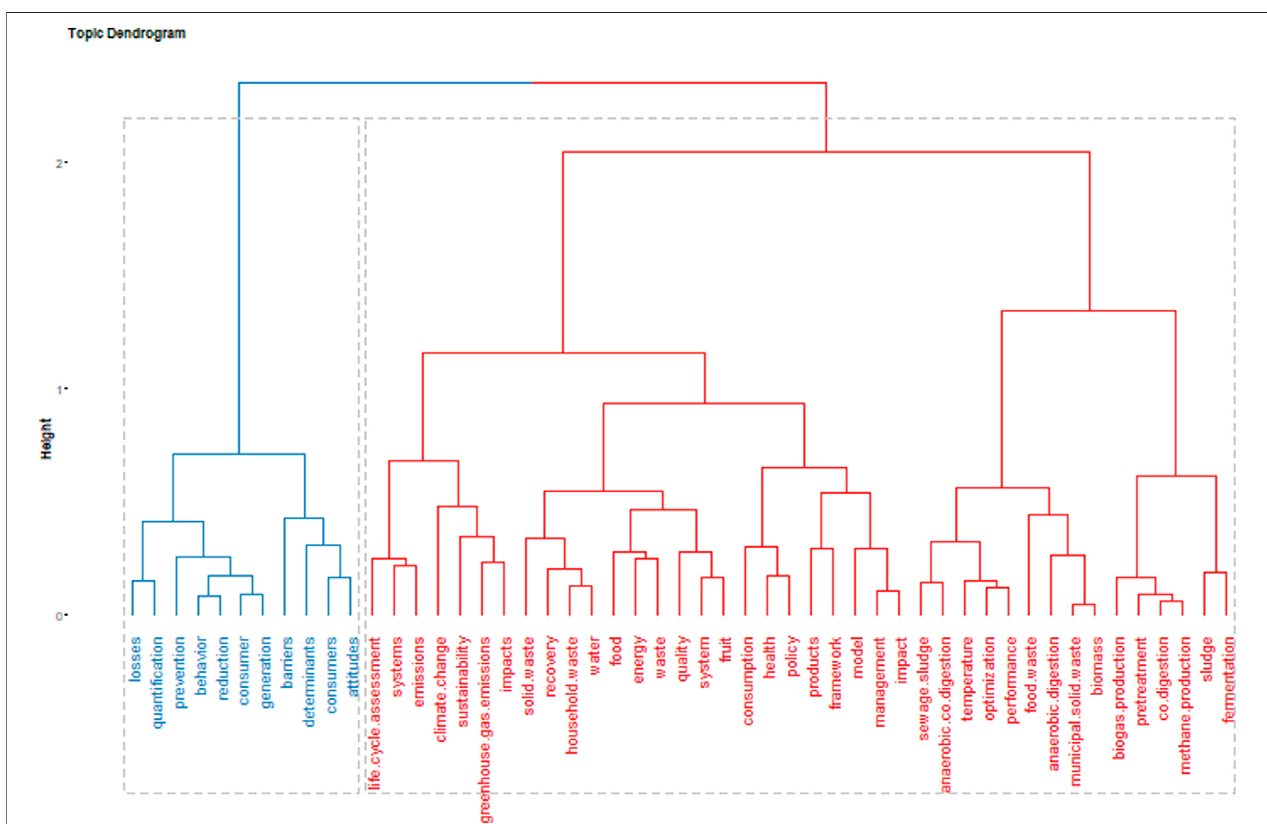
FIGURE 4 | Dendrogram of